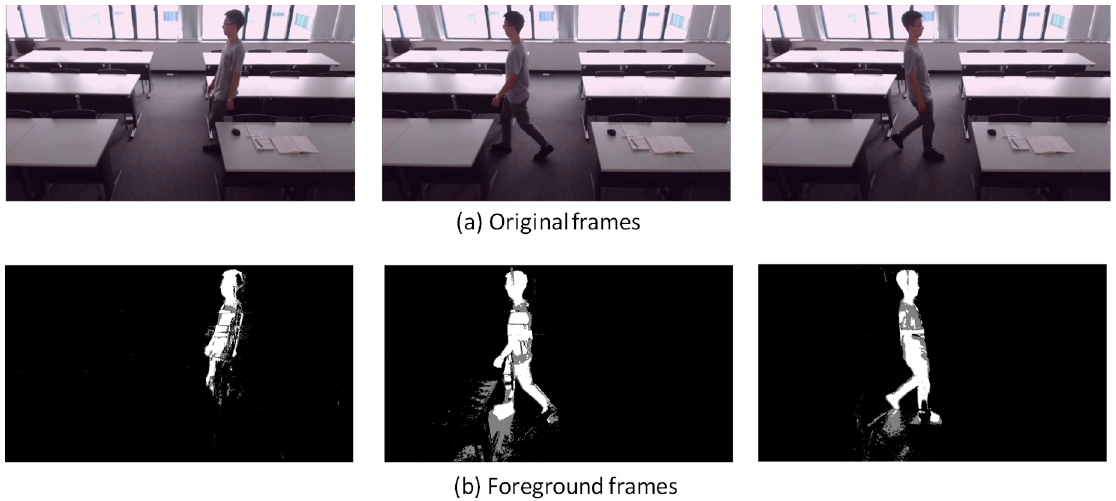
Figure 8. Walking (1.2 m/s)—sample images.